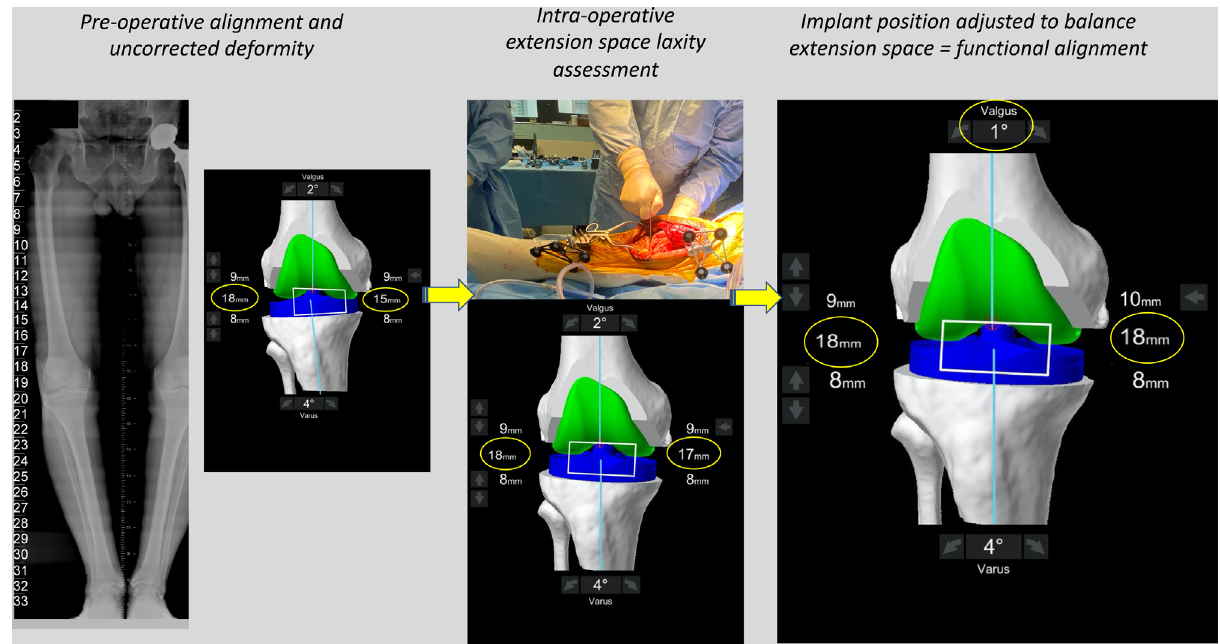
Figure 4. Intra-operative assessment of the extension space. The limb is placed in a corrected position, and the robot “ captures ” the pose. The personalized plan will deliver extension gaps of 18 mm laterally and 17 mm medially. In order to achieve balanced compartments, the plan is modi fi ed in this case by decreasing the femoral